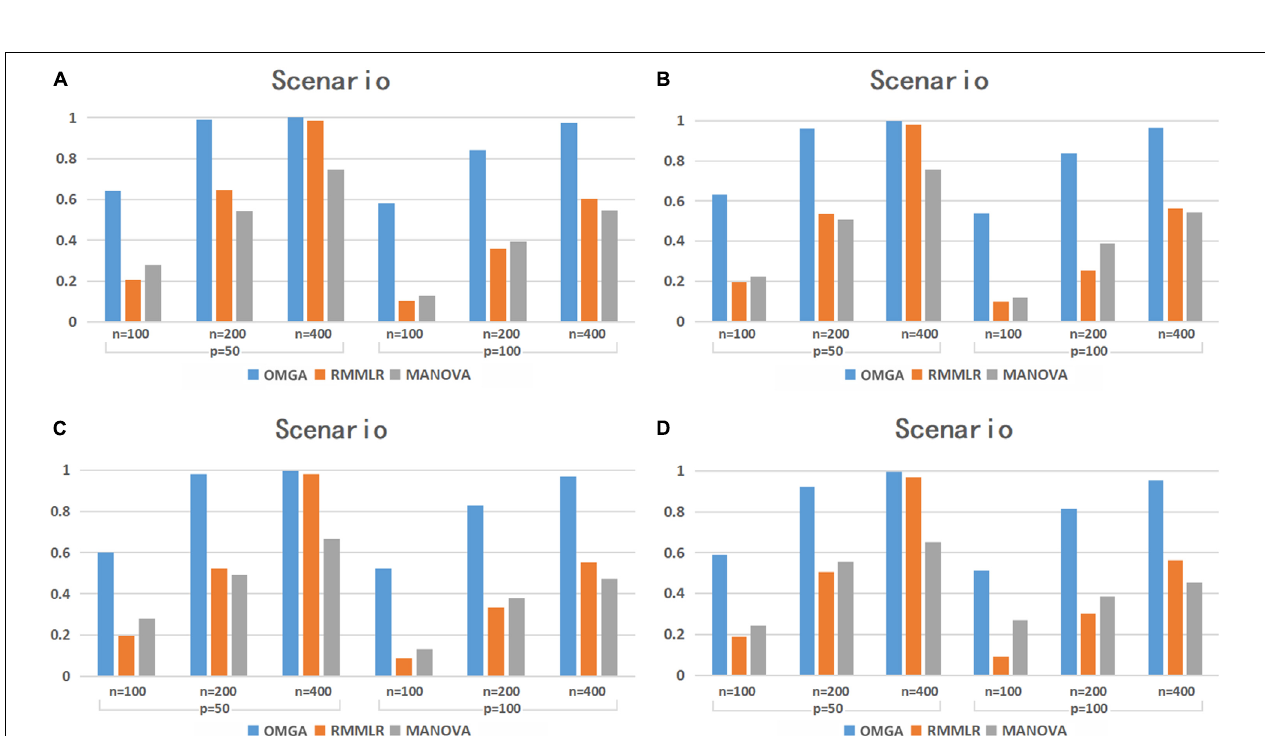
FIGURE 2 | The testing power of different methods under the four scenarios with p =